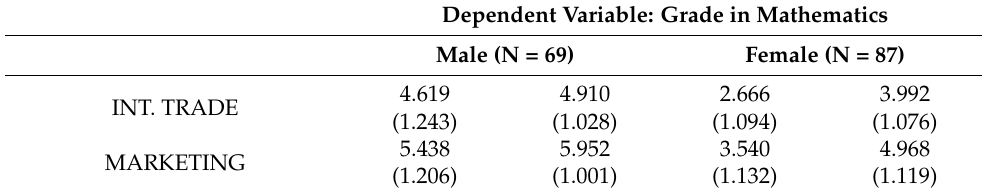
Table A2. Coefficients of linear models explaining grades by